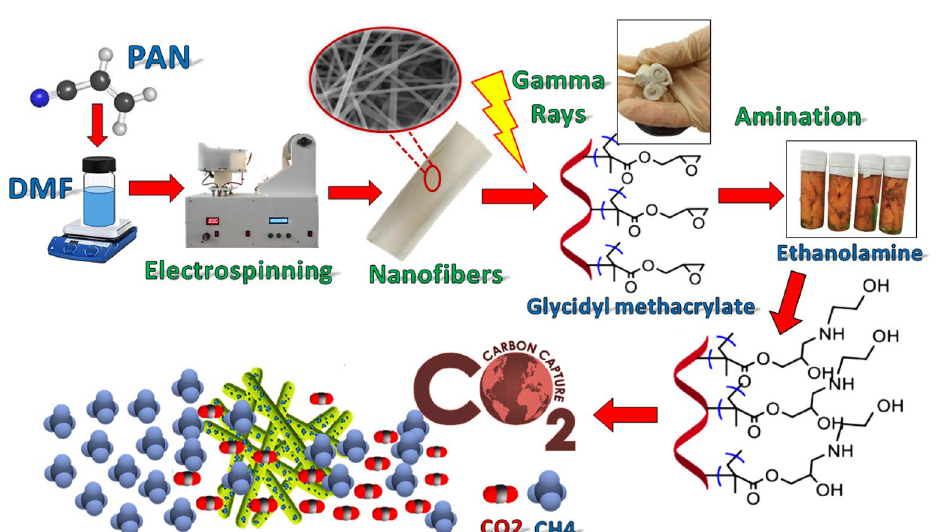
Figure 1. Schematic procedure for the preparation of the polymeric